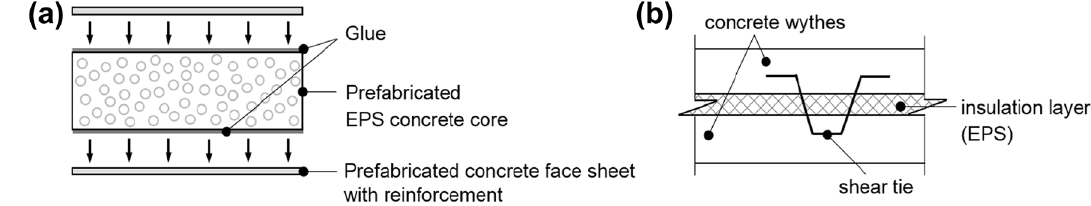
Fig. 1 Concept of composite sandwich panels; a EPS concrete sandwich panel and b typical concrete sandwich